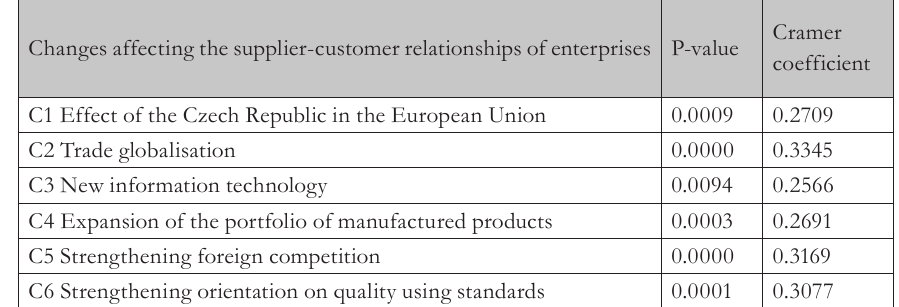
Tab. 3 – Results of hypotheses testing. Source: Survey